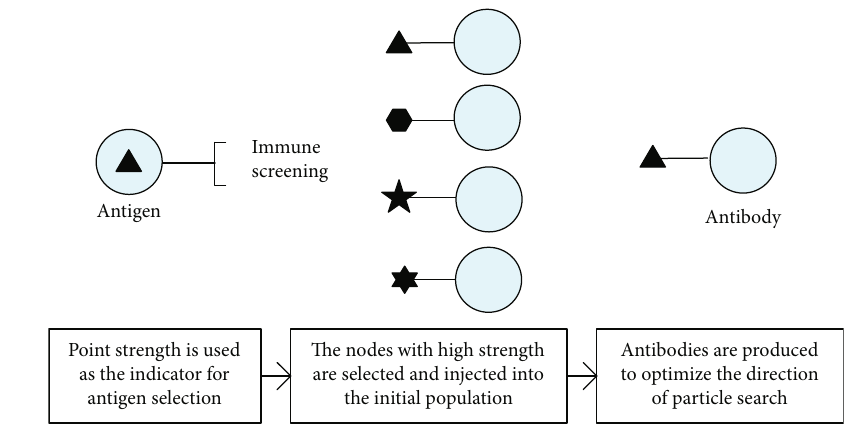
Figure 8: Explanation of immune mechanism.